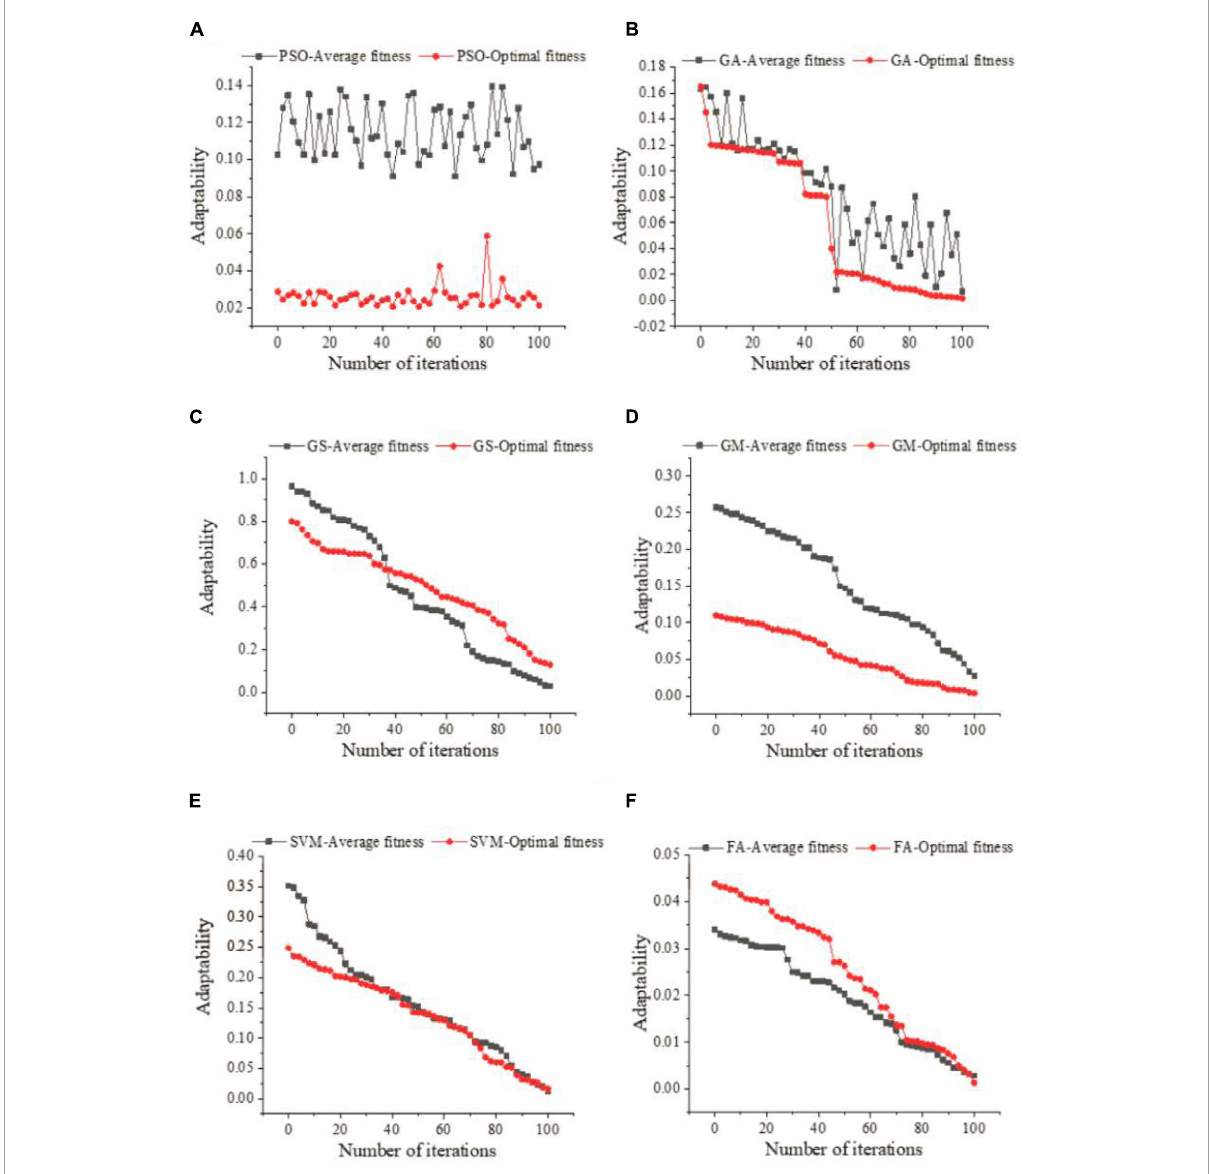
FIGURE6 (A) Parameter optimization curve of PSO algorithm. (B) Parameter optimization curve of GA algorithm. (C) Parameter optimization curve of GS algorithm. (D) Parameter optimization curve of GM algorithm. (E) Parameter optimization curve of SVM algorithm. (F) Parameter optimization curve of FA